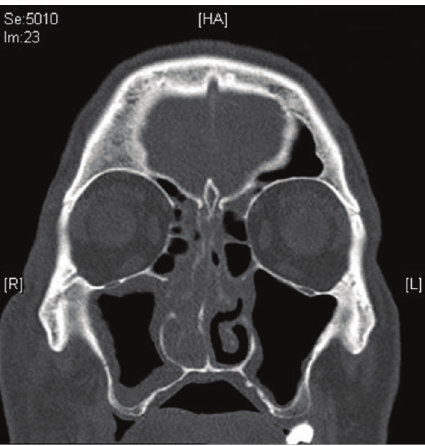
Figure 1: Coronal CT view of sinuses showing right-sided sinusitis with mucosal thickening of the maxillary sinus and anterior eth- moids.